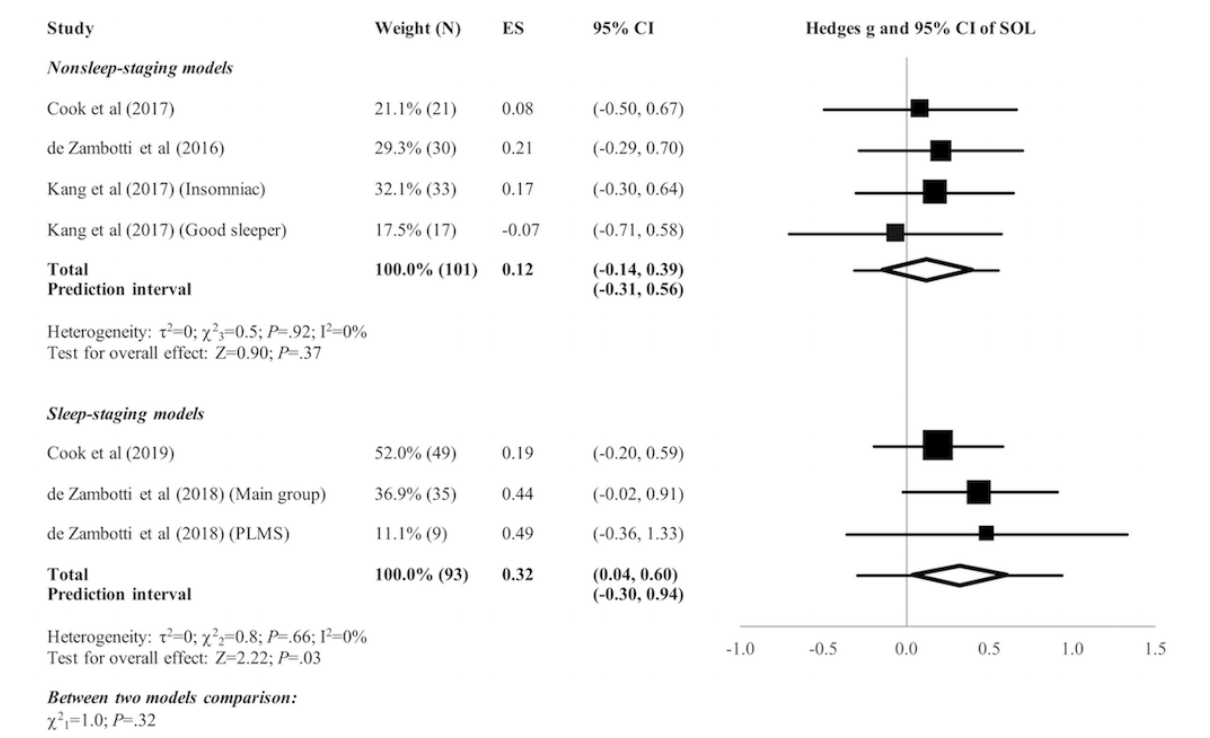
Figure 2. Forest plot of the standardized mean difference (Hedges g) between Fitbit and polysomnography for the variable of sleep onset latency (SOL). Results are shown as effect size (ES) and 95% CI. The difference in symbol size indicates the difference in weight of the respective studies. The diamond symbol shows the 95% CI of the overall effect and the tails show the 95% prediction interval of the overall effect. PLMS: periodic limb movement in sleep.